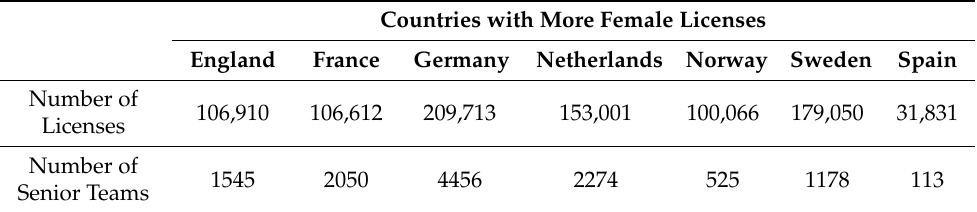
Table 5. Number of licenses, teams and national teams in six European countries with more female licenses in comparison with